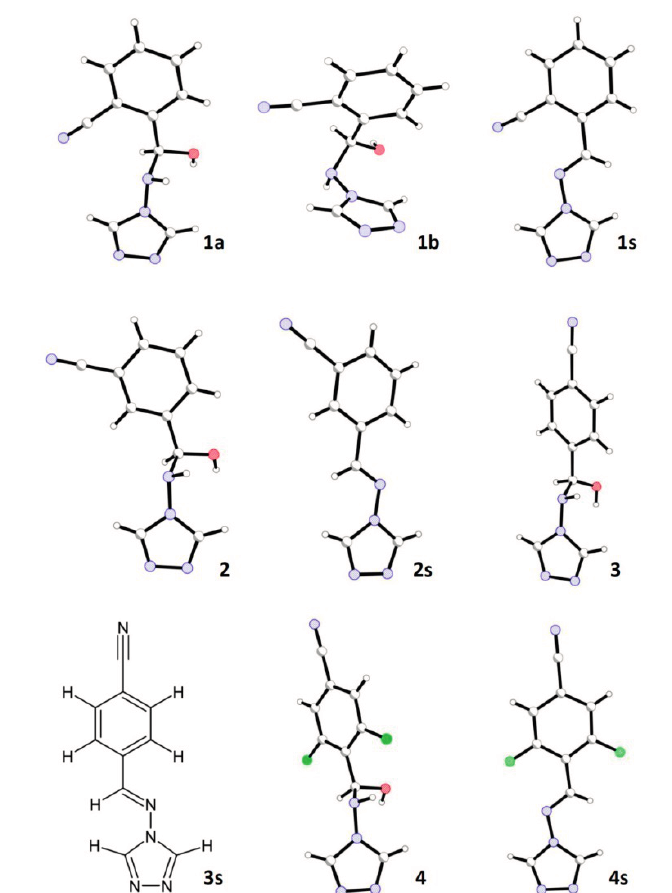
Figure 1. Molecular structures of the new